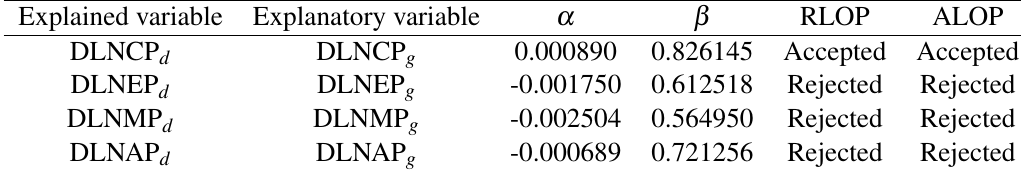
Table 2 Estimation results of regression coefficient and test results of constraint conditions